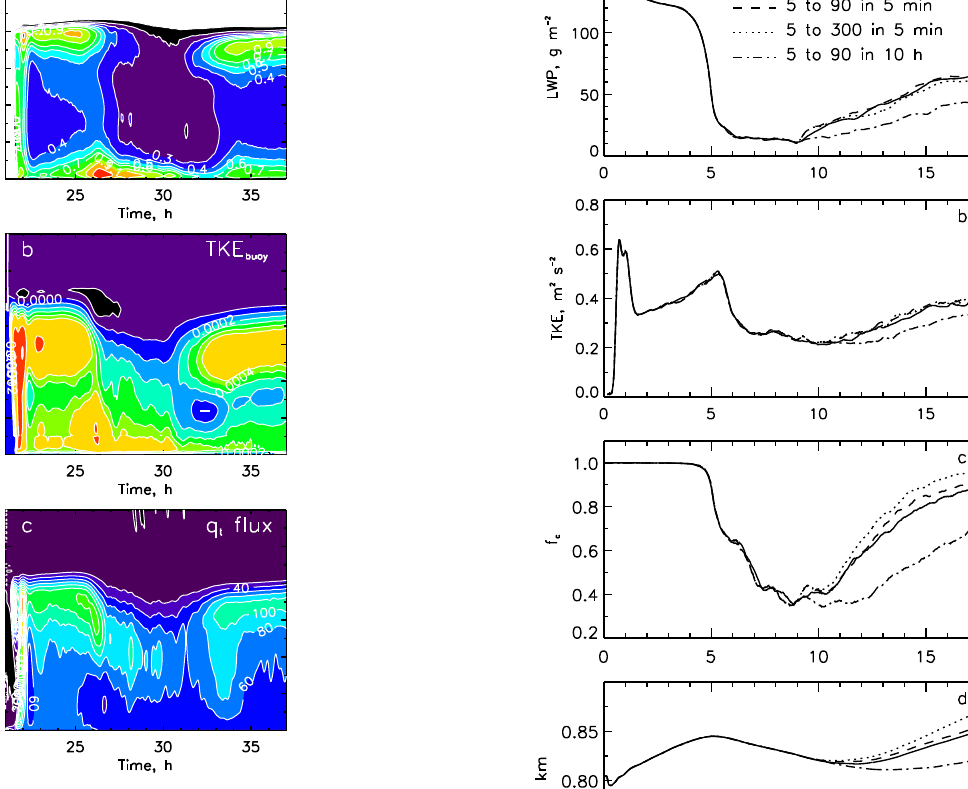
Figure 8. Time–height cross sections associated with Fig. 7: (a) re- solved TKE (m 2 s − 2 ), (b) buoyancy production of TKE (m 2 s − 3 ), and (c) q t flux (Wm − 2 ). Note how in (a) , the peak TKE transitions from the cloud layer to the surface during closed-to-open cell tran- sition ( t ≈ 26h) and back to the cloud layer upon recovery. In (b) , an area of negative buoyancy production of TKE (consumption) is indicated by a white minus sign ( t ≈ 33h). After the disappearance of this region of buoyancy consumption of TKE, stronger q t flux into the cloud is evident (panel c , t ≈ 33h).